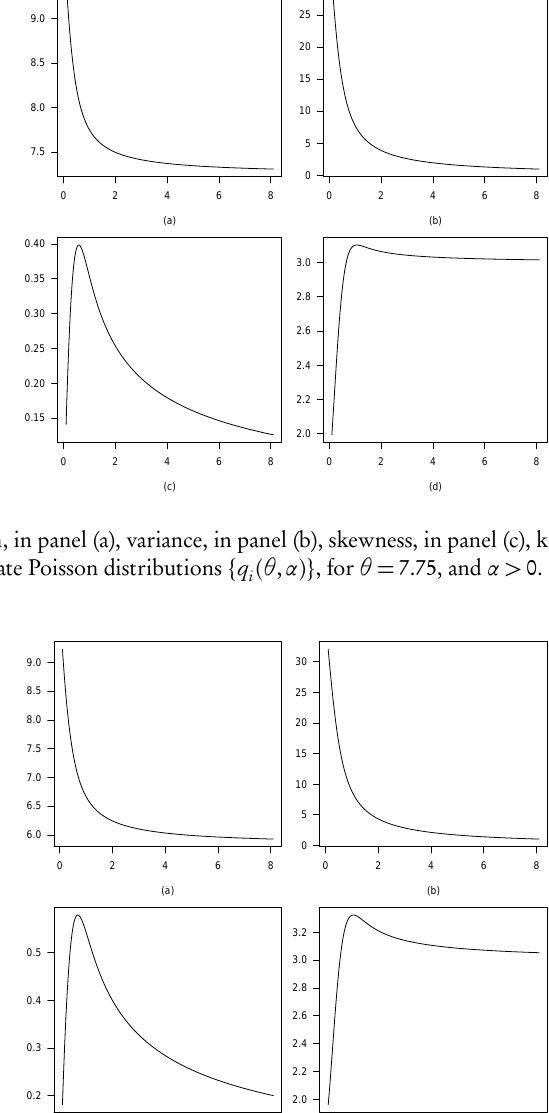
Figure 14 – Mean, in panel (a), variance, in panel (b), skewness, in panel (c), kurtosis, in panel (d), of the intermediate negative binomial distributions { q